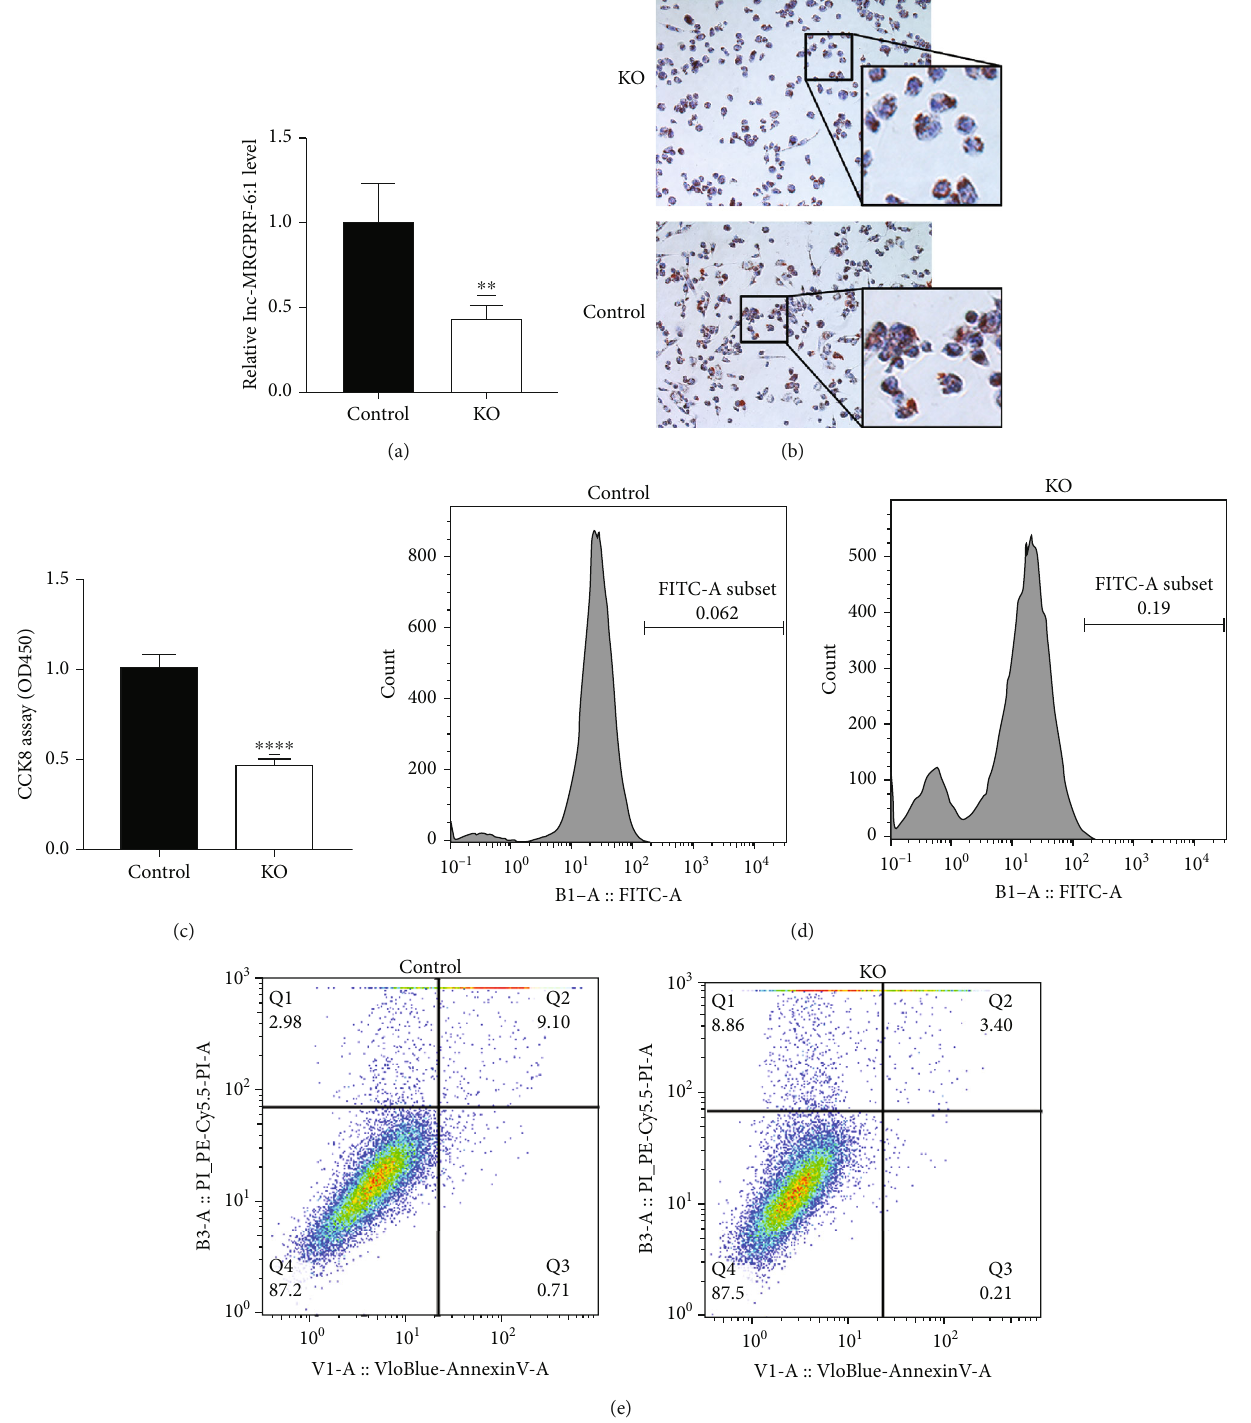
Figure 2: Knockout of lnc-MRGPRF-6:1 can reduce the lipid accumulation and ROS levels of foam cells, signi fi cantly increase the viability of macrophages, and inhibit cell apoptosis. After the lnc-MRGPRF-6:1 knockout macrophage was induced to di ff erentiate with the control cells, the cells were stimulated with 50 mg/mL ox-LDL for 24h. (a) The expression level of lnc-MRGPRF-6:1 between KO and control was detected by RT-qPCR. (b) Image of Oil Red O staining. (c) Viability of macrophage. (d) ROS levels in macrophage. (e) Apoptosis level of macrophage. KO vs. control, ∗ P < 0 : 05 , ∗∗ P < 0 : 01 , ∗∗∗ P < 0 : 001 , and ∗∗∗∗ P < 0 : 0001 . KO: lnc-MRGPRF-6:1 knockout macrophage; control: macrophage infected by control